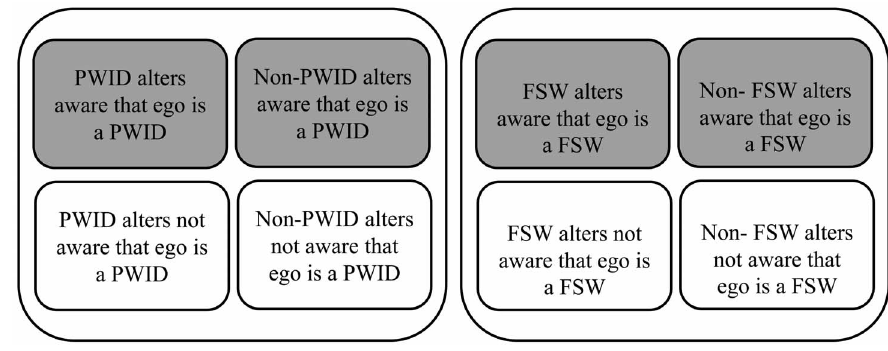
Figure 1. The four strata for collecting the number of alters in PWID and FSW survey.